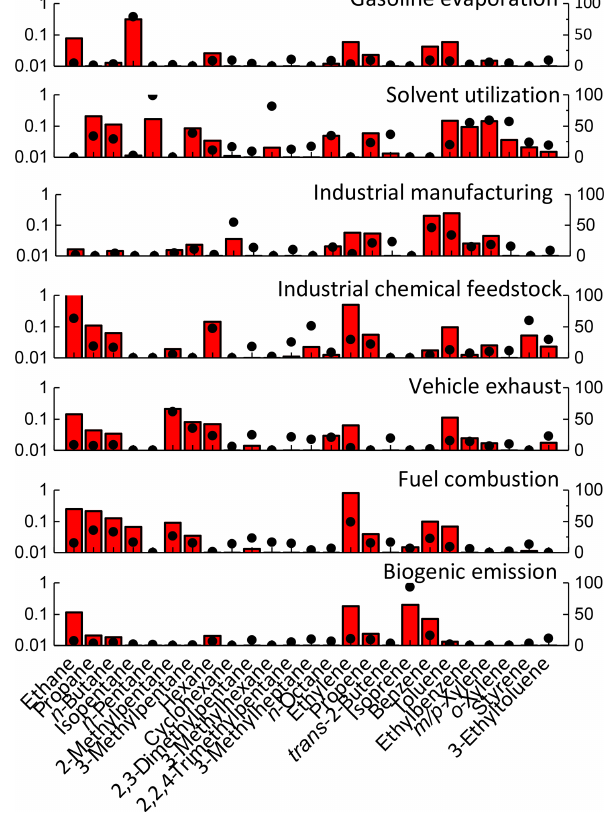
Figure 5. Seven source profiles and their respective contribution resolved from PMF model. The bars are the profiles (ppbv, left axis), and the dots are the percentage contribution (%, right axis) from individual